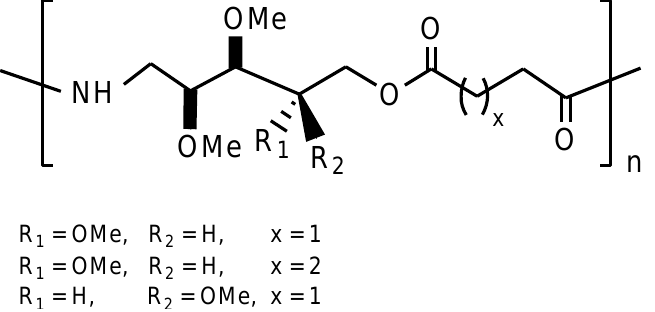
Figure 19. Chemical structure of poly(ester amide)s derived from L-arabinose or D-xylose.